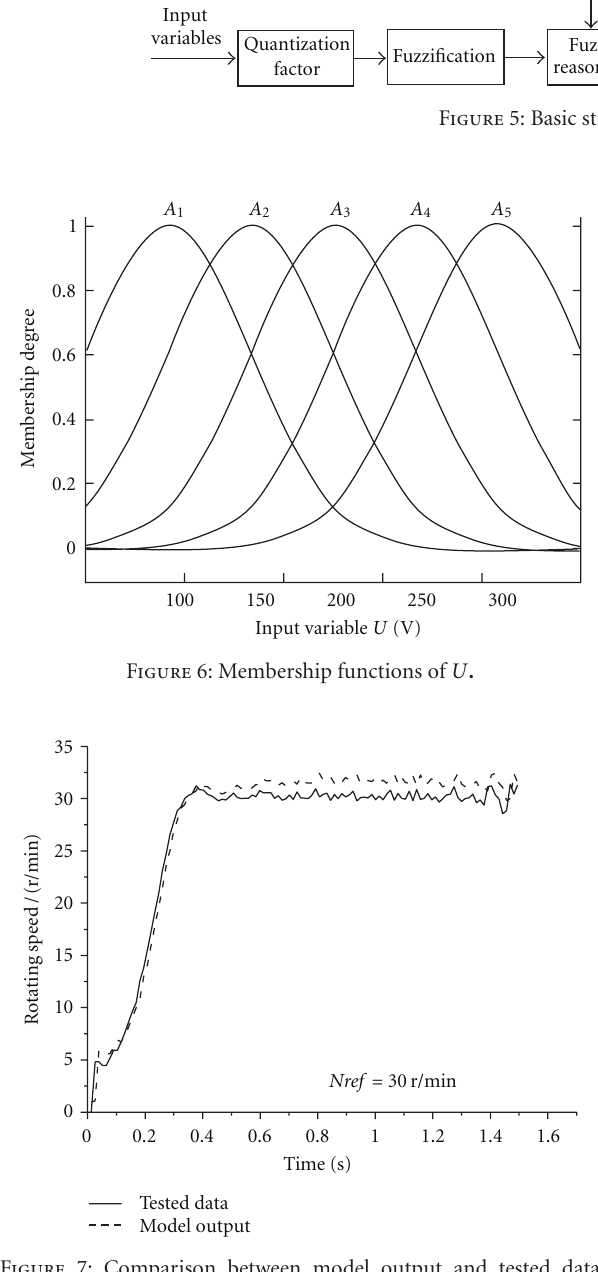
Figure 9: Membership functions of U